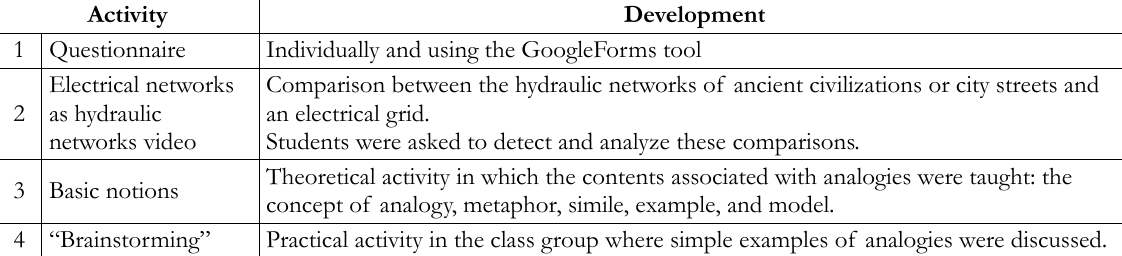
Table 2. Activities at the beginning of session